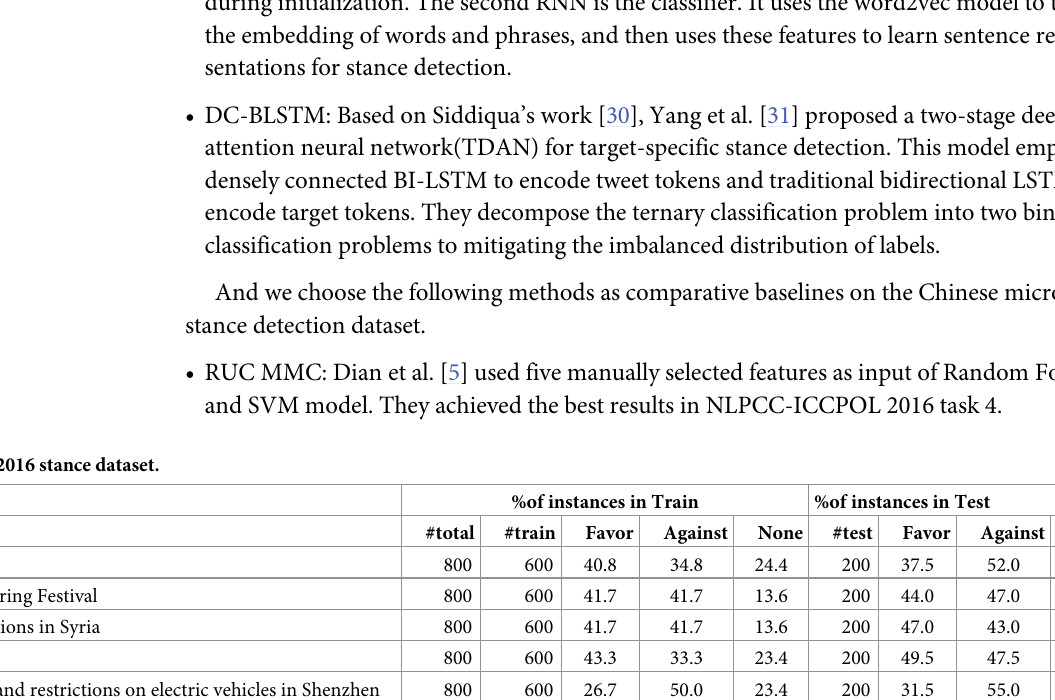
The Chinese dataset contains 4,000 Chinese microblogs with stance labels, among which